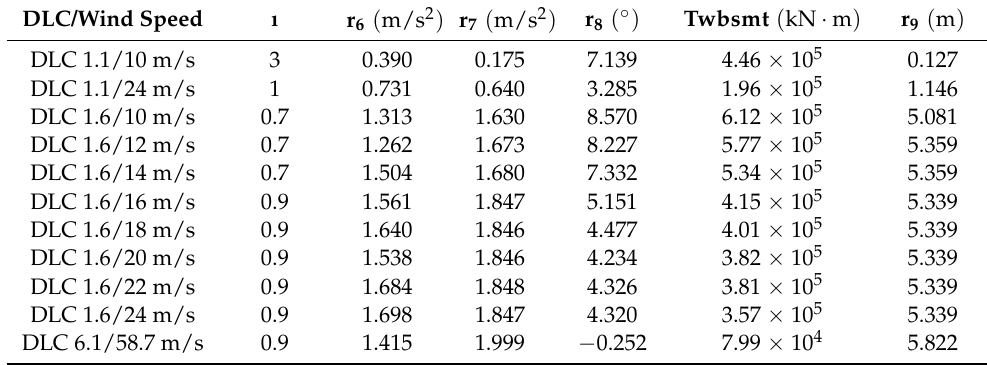
Table 25. Control scheduling and platform motions.